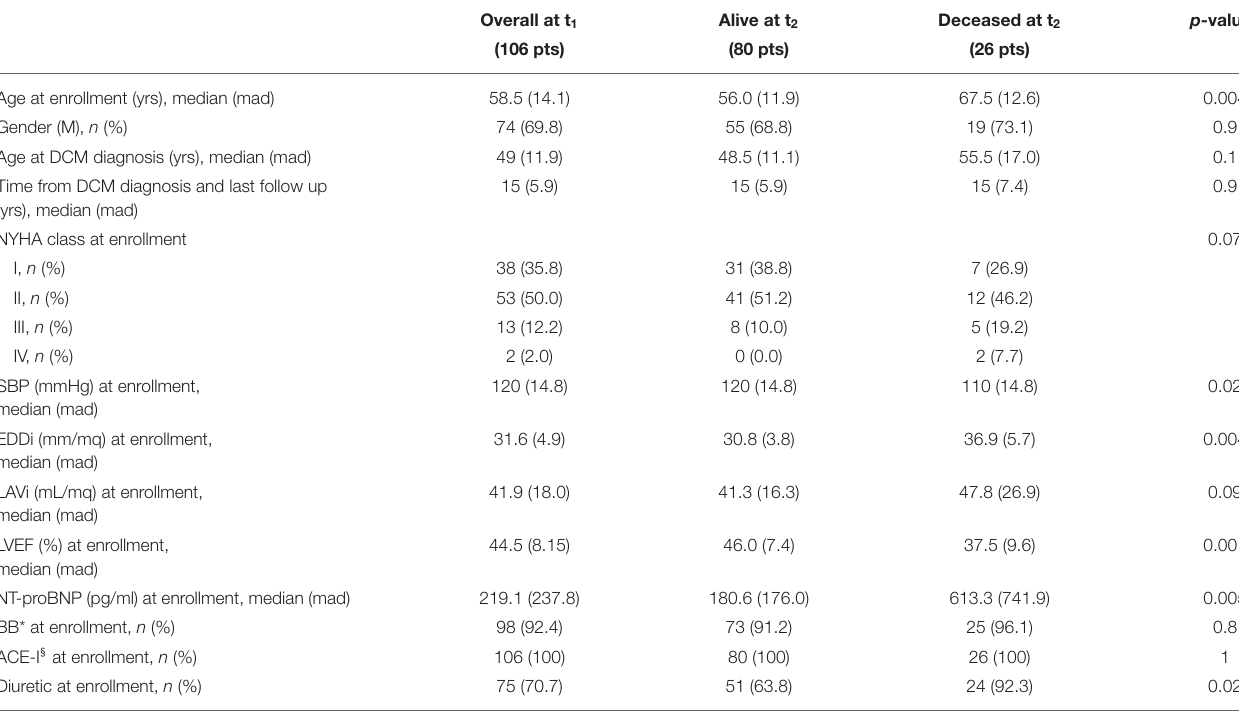
TABLE 1 | Baseline characteristics of enrolled patients.